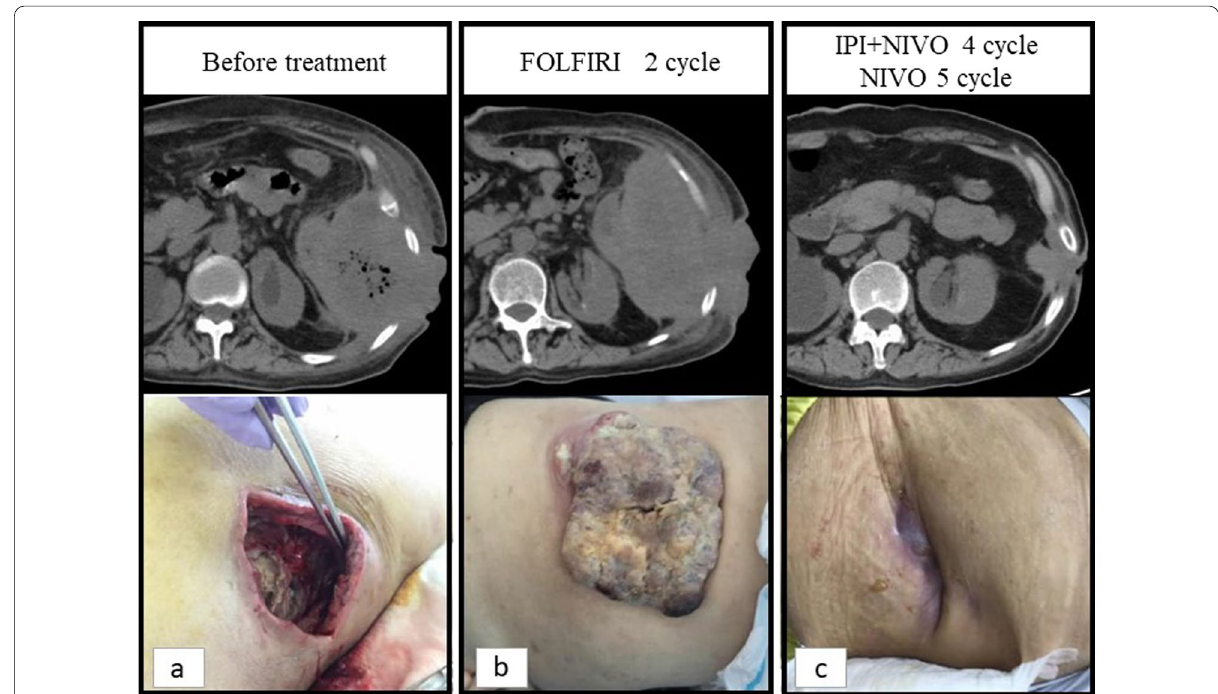
Fig. 1 Computed tomography and pictures of the tumor according to the course of anticancer therapy. a Before treatment. b After two cycles of FOLFIRI therapy. c After four cycles of nivolumab and ipilimumab combination therapy and five cycles of nivolumab